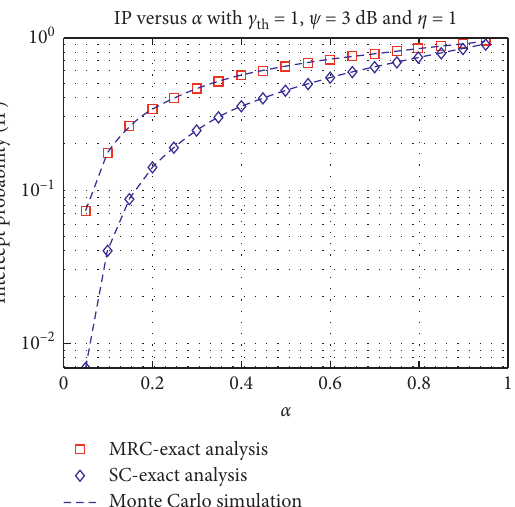
Figure 4: OP versus Ψ ( dB ) .